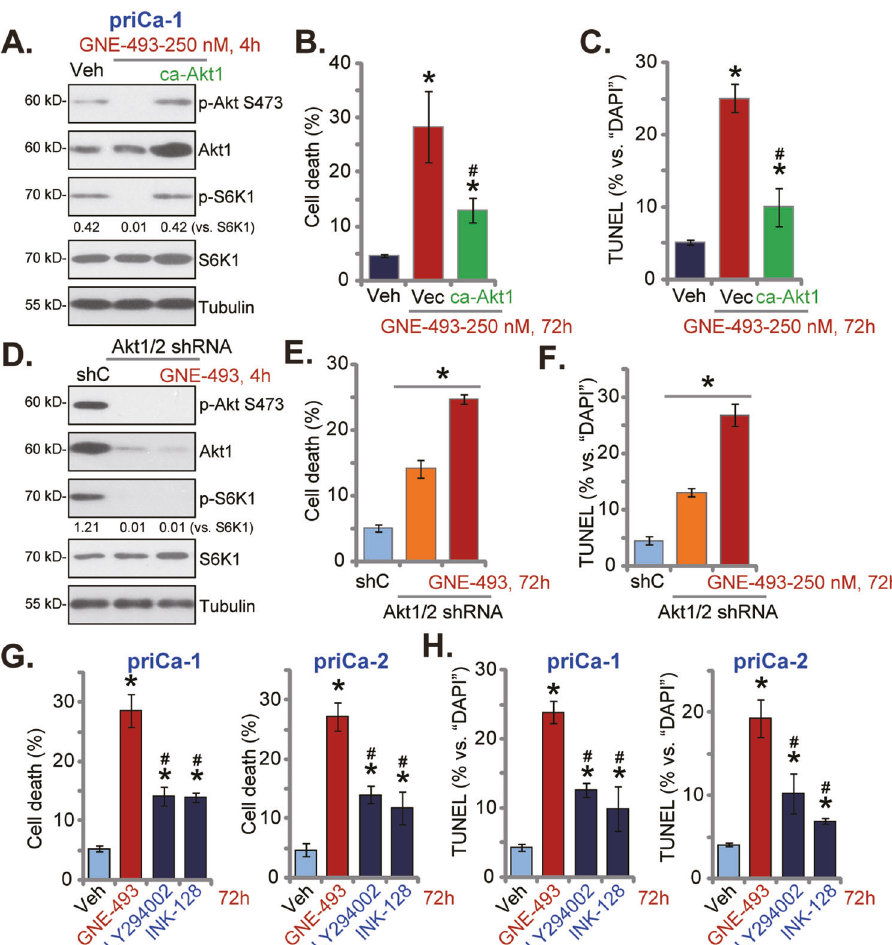
Fig. 3 GNE-493 blocks Akt-mTOR activation in prostate cancer cells. The priCa-1 cells were infected the recombinant adenovirus encoding the constitutively-active mutant Akt1 (caAkt1, S473D, for 72 h), followed by GNE-493 (250 nM) stimulation for designated time, control cells were treated with vehicle control; western blotting assays showed expression of listed proteins n ( A ); cell death (by measuring Trypan blue- positive cell percentage, B ) and cell apoptosis (by measuring the TUNEL-positive nuclei percentage, C ) were tested. priCa-1 cells stably expressing the lentiviral Akt1/2 shRNA (Akt1/2 shRNA, for 72 h) were stimulated with or without GNE-493 (250 nM); control shRNA lentiviral particles ( “ shC ” ) were added to the control cells. Cells were further cultivated for designated time, listed proteins were shown ( D ); cell death (by measuring Trypan blue-positive cell percentage, E ) and apoptosis (by measuring TUNEL-positive nuclei percentage, F ) were tested. The primary human prostate cancer cells, priCa-1 or priCa-2, were treated with 250 nM of GNE-493, LY294002, INK-128, or the vehicle control (0.25% DMSO, “ Veh ” ) and cells were cultivated for 72 h, cell death ( G ) and cell apoptosis ( H ) were tested similarly. * P < 0.05 versus “ Veh ” group ( B , C , G , and H ). # P < 0.05 versus “ Vec ” cells ( B and C ). * P < 0.05 ( E and F ). # P < 0.05 versus GNE-493 treatment ( G and H